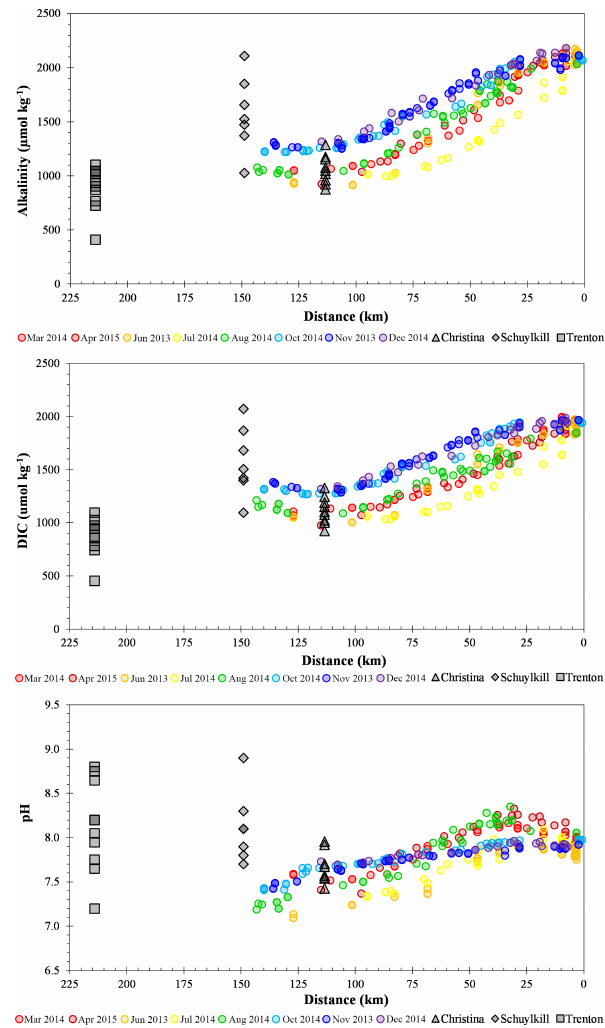
Figure 5. Spatial distribution of alkalinity, DIC, and pH in the Delaware Estuary from the mouth of the bay (0km) to the head of the tide at Trenton, NJ (215km).